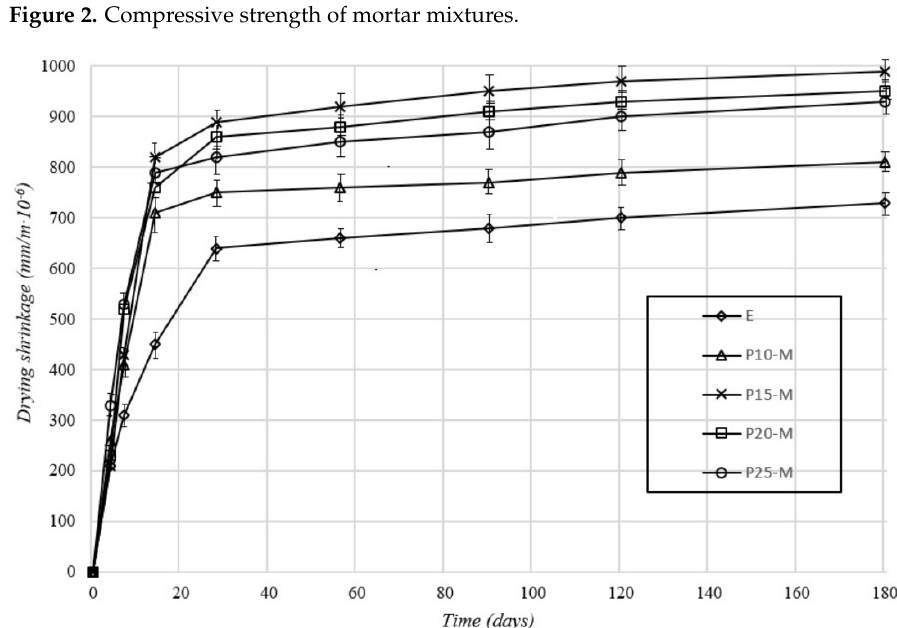
Figure 2. Compressive strength of mortar mixtures.